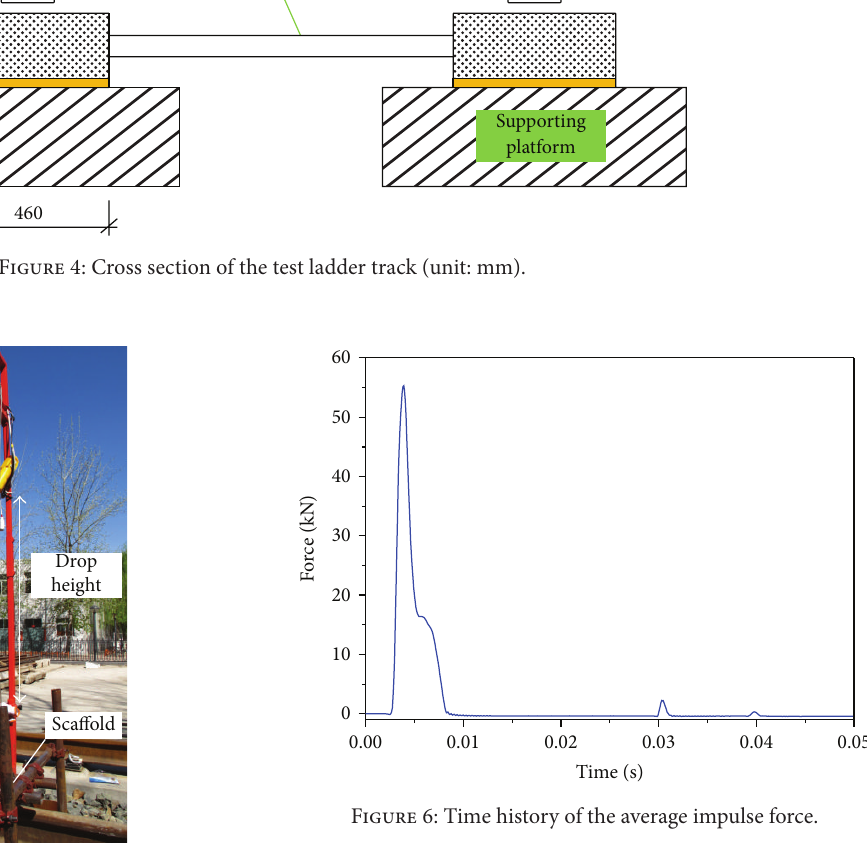
Figure 5: Automatic falling weight machine.